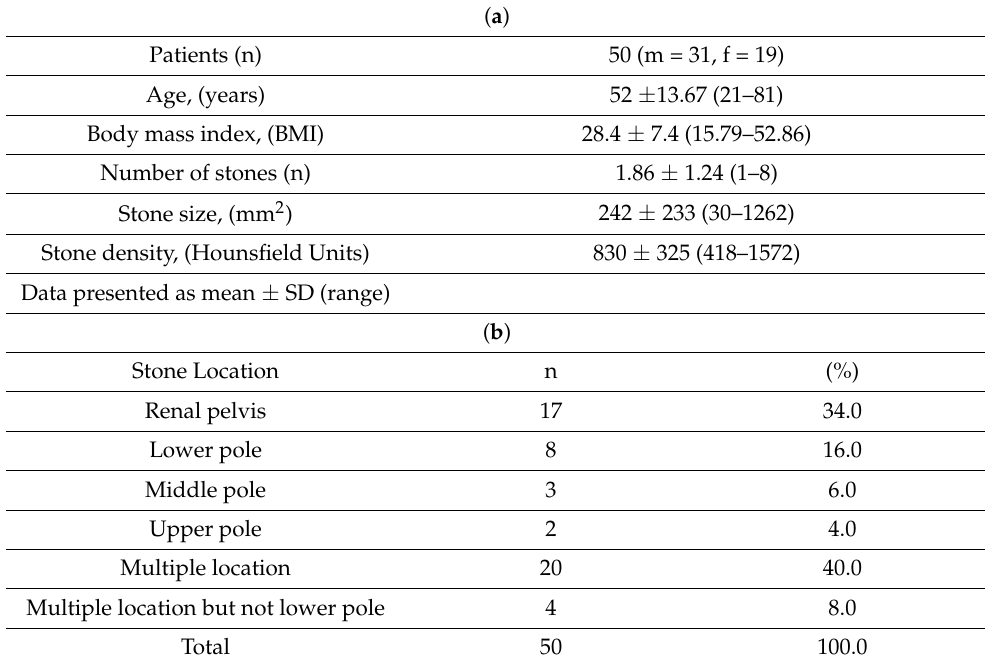
Table 1. a —Patient characteristics (n = 50). b —Stone characteristics.